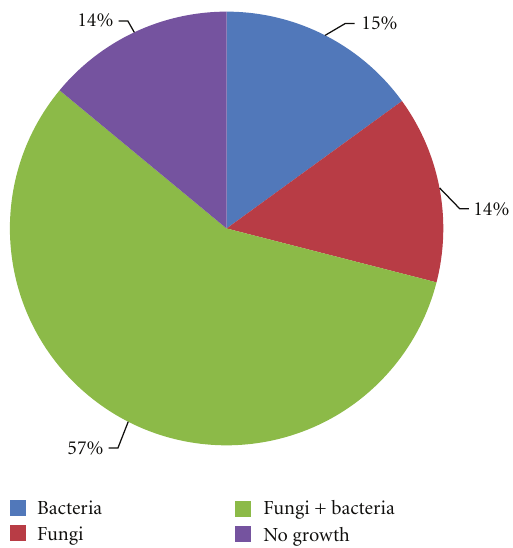
Figure 1: Cultivation results of milk samples from cows su ff ering from